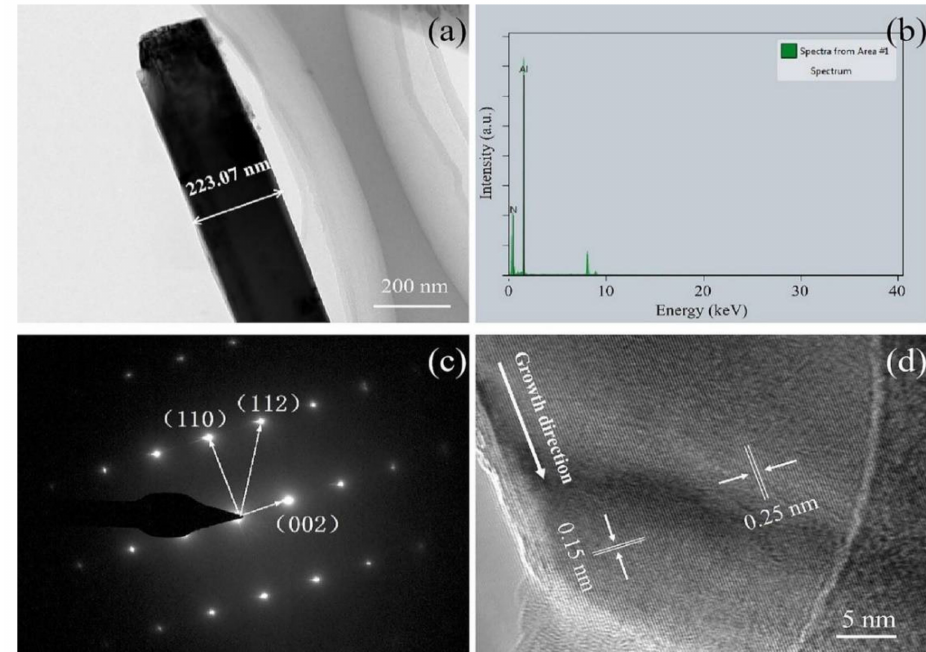
Figure 4. ( a ) TEM image of a single AlN nanowire; ( b ) EDS analysis of the AlN nanowire; ( c ) SAED pattern of the AlN nanowire; and ( d ) HRTEM image of the AlN nanowire.